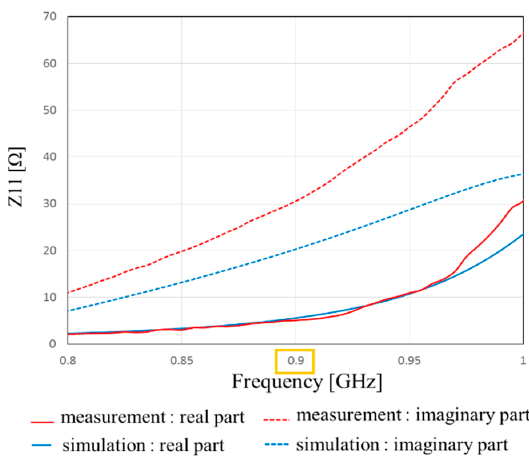
Figure 19. Frequency characteristics of Z 11 of the proposed antenna with impedance matching circuit calculated from s-parameters.